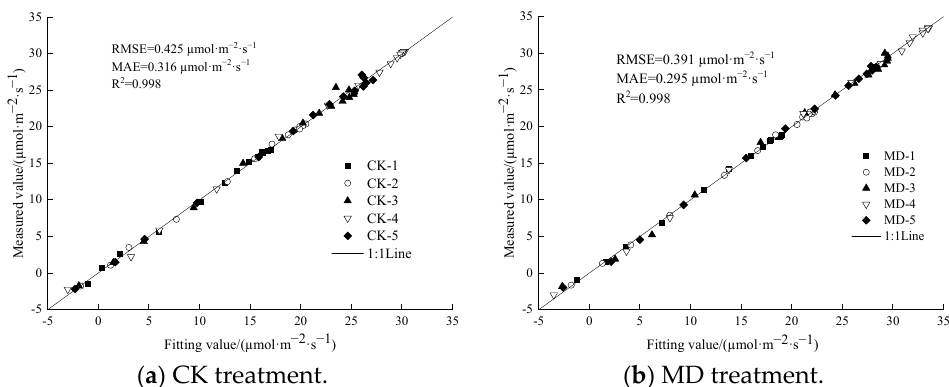
Figure 7. Fitting value and the measured value of P n by the modified rectangular hyperbolic model under different soil moisture contents. CK-1, CK-2, CK-3, CK-4, and CK-5 indicate that the soil moisture content is controlled at 45–55%, 55–65%, 65–75%, 75–85%, and 85–95% of the field capacity with conventional water, respectively; MD-1, MD-2, MD-3, MD-4, and MD-5 indicate that the soil moisture content is controlled at 45–55%, 55–65%, 65–75%, 75–85%, and 85 − 95% of the field capacity with magnetoelectric water, respectively. RMSE, root mean square error; MAE, mean absolute error. The photoresponse curve mathematical model was used to calculate P n max .